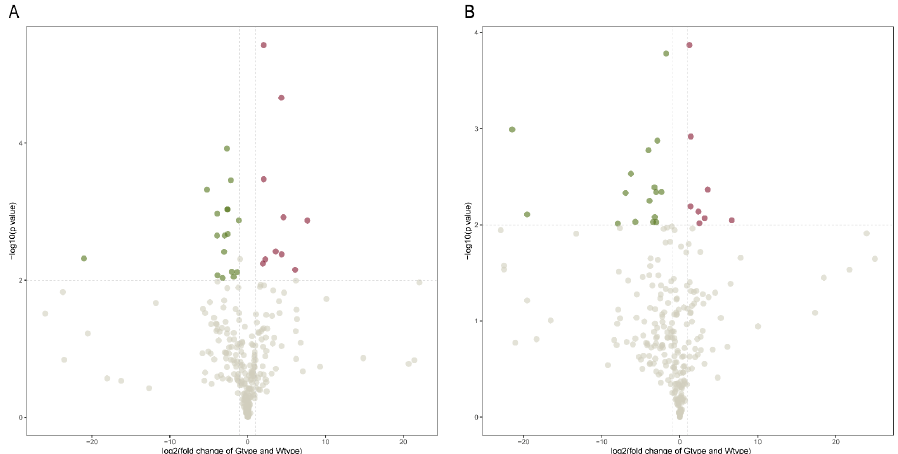
Figure 4. Volcano plots of significantly different metabolites of the two types of P. sibiricum acquired in positive ( A ) and negative ( B ) ionization modes. The negative logarithm of the p -value was used as the vertical axis (base 10), and the logarithm of fold change (base 2) between Gtype and Wtype samples was used as the horizontal axis. Each point in the volcano plot represents a metabolite. In order to further identify the biomarkers that better distinguish the two types of P. sibiricum samples, the supervised PLS-DA modeling based on the 27 differentially altered metabolites that were identified in positive ionization mode or 24 differentially altered metabolites that were identified in negative ionization mode was utilized. As shown in the PLS-DA score plots, the samples were clearly distinct and in line with their types (Fig- ure 5A,C). In cross-validation of the PLS-DA model for positive ionization mode, the model fit (R 2 ) and predictiveness (Q 2 ) values were both found to be 0.99, suggesting good fitness and predictive power of this model. For negative ionization mode, R 2 and Q 2 values